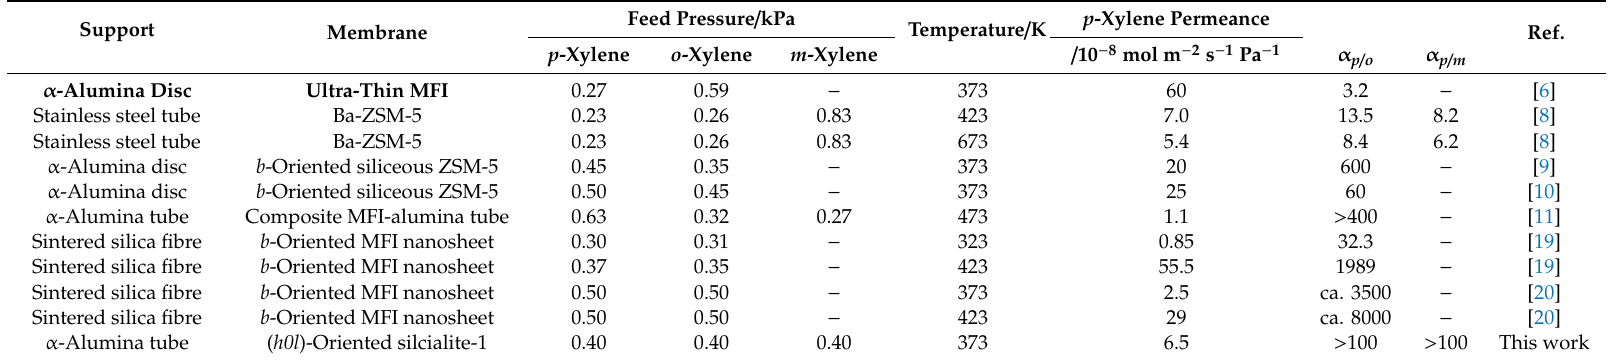
Table 1. Comparison of permeation and separation performance of the MFI-type zeolite membrane for xylene